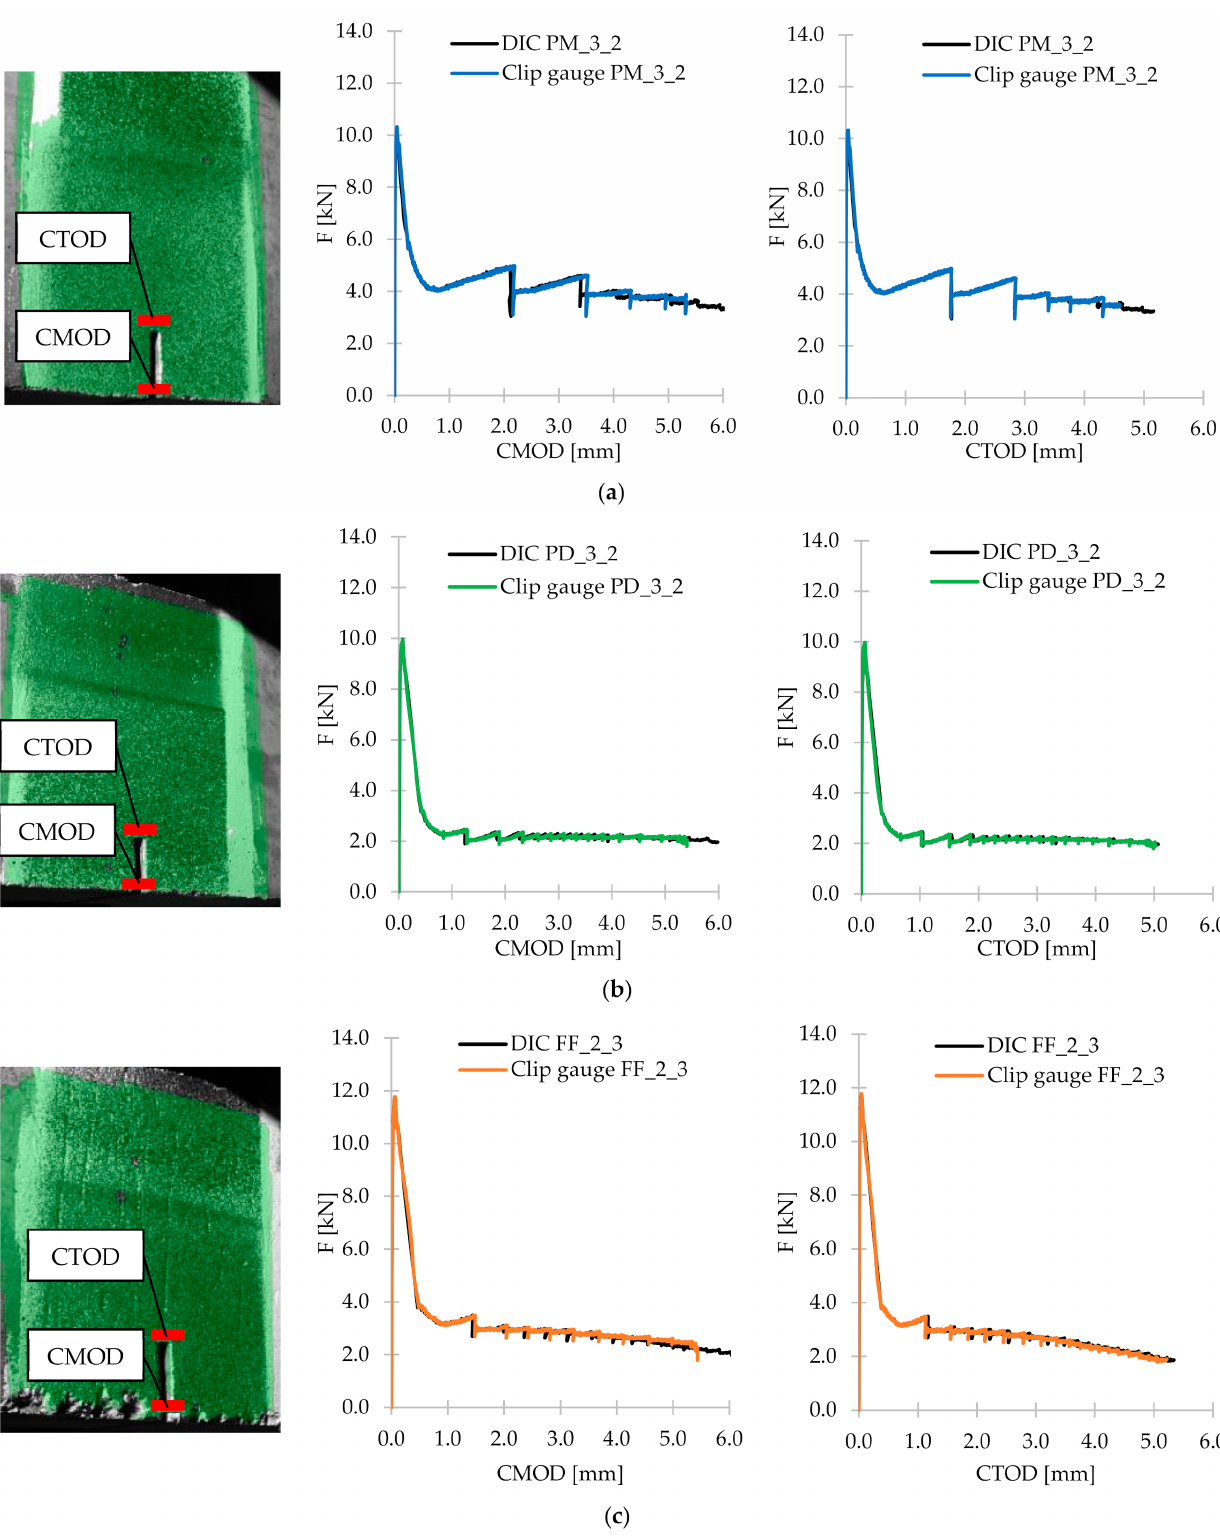
Figure 23. Comparison of CMOD and CTOD results from clip gauges and the DIC system for selected samples: ( a ) PM_3_2; ( b ) PD_3_2; ( c )